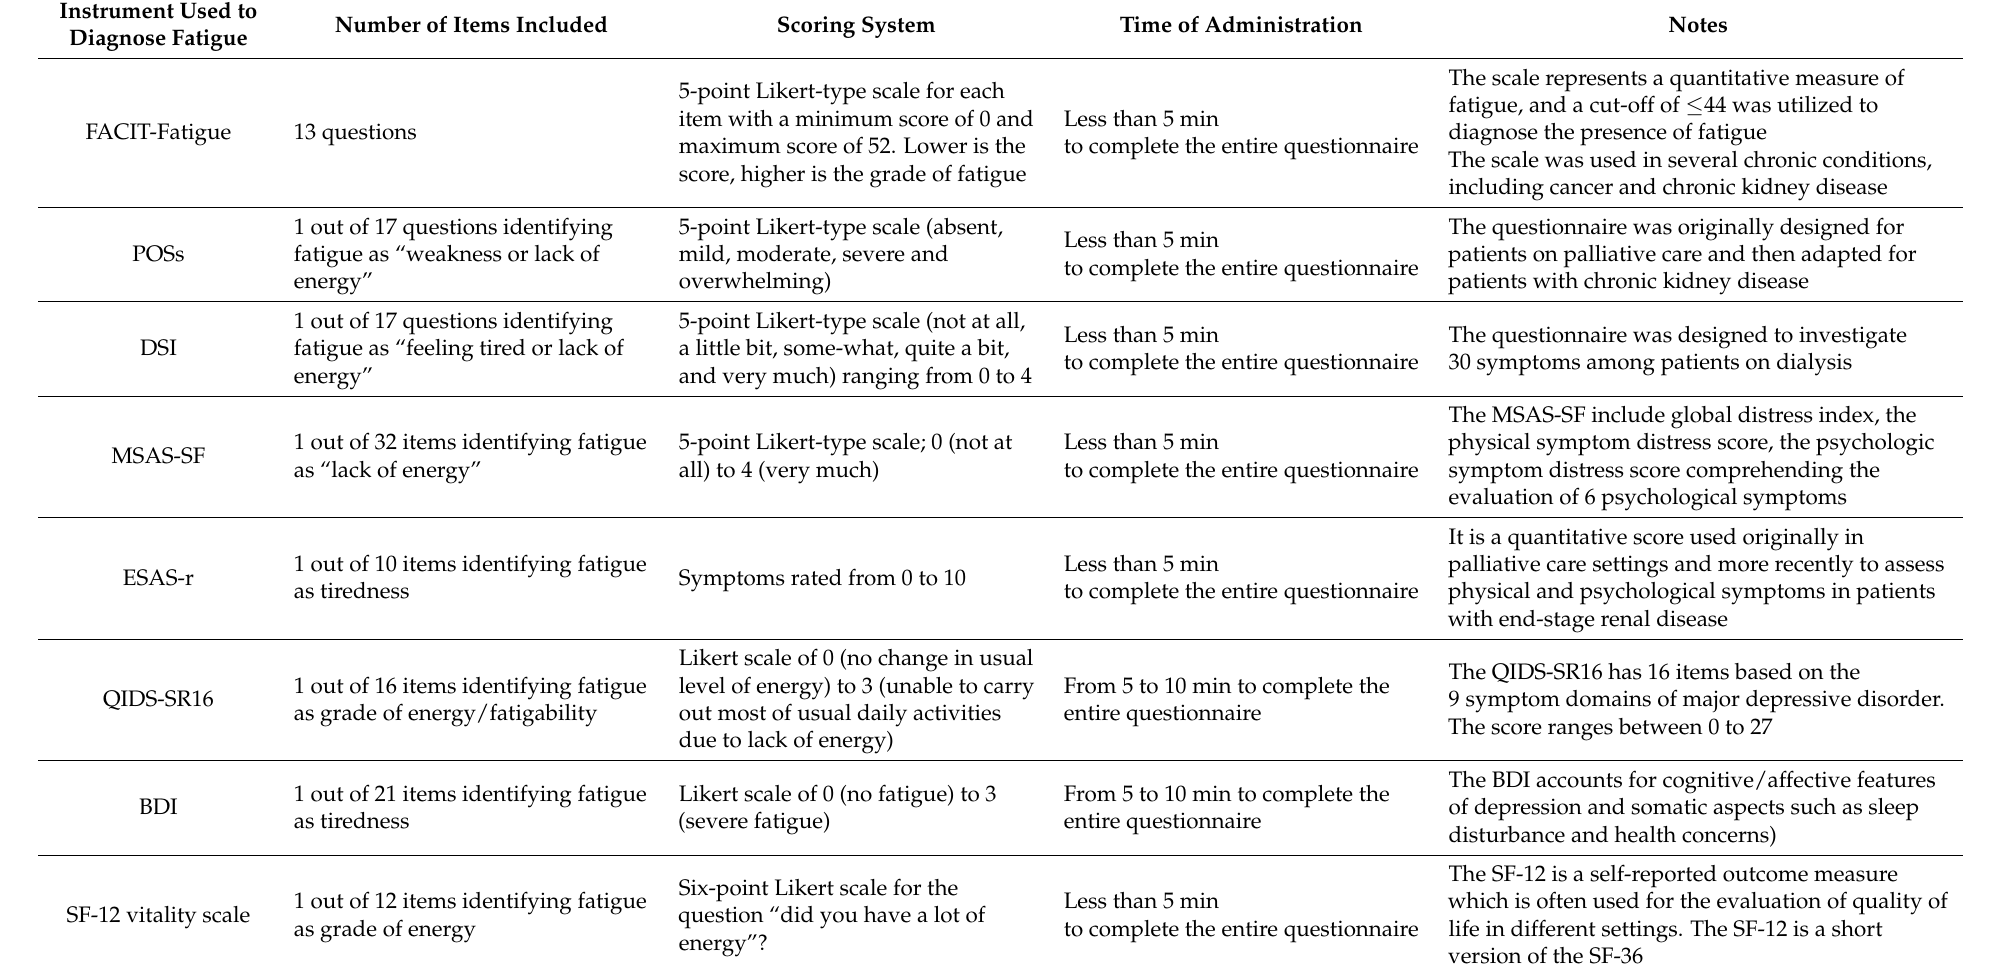
Table 3. Summary of the characteristics of the main tools used for the assessment of fatigue in patients with chronic kidney diseases. Instrument Used